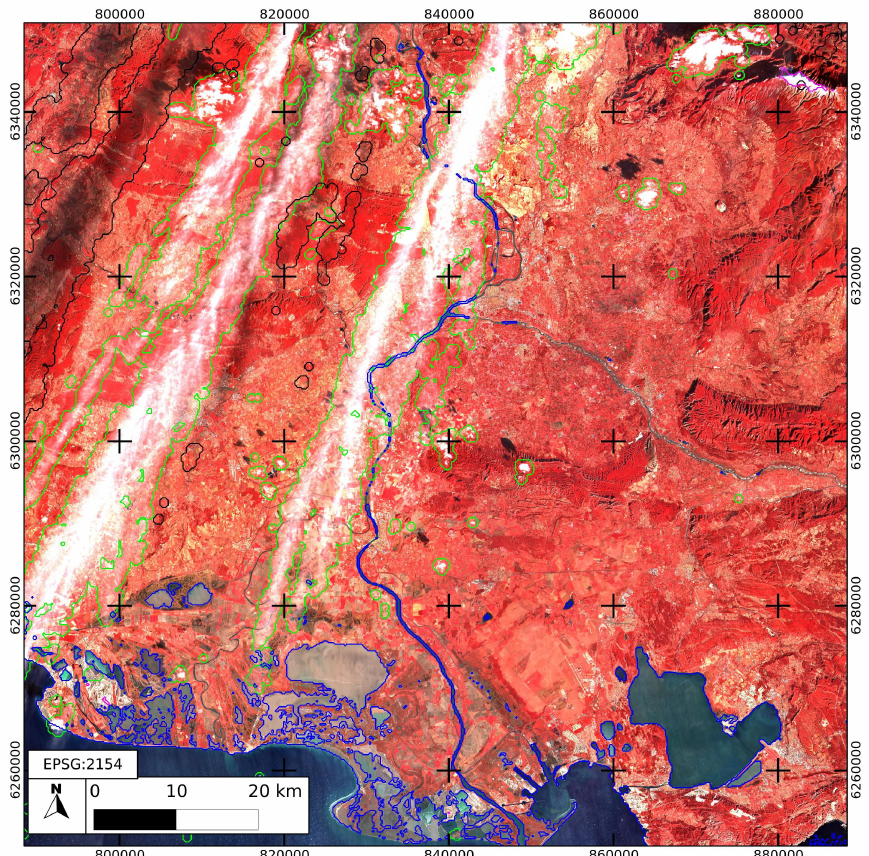
Figure 5. On this SPOT-4 (Take 5) image acquired in Provence, the cloud mask is outlined in green, the cloud shadow mask in black, the water mask in blue and the snow mask in pink (in the northeast corner). One can note that faint clouds and cloud shadows are well detected. Image c (cid:13) CNES (2013), all rights